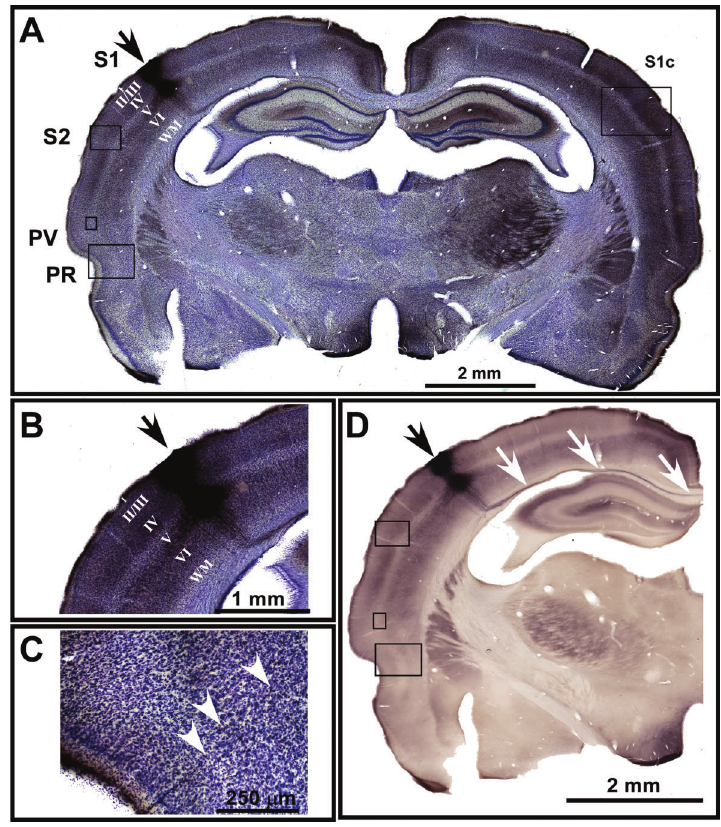
Figure 2 . Histological rat brain section double- stained with Nissl showing the laminar location of labeled corticocortical axon terminals after a single iontophoretic injection of biotinylated dex- tran amine in S1. A , Low-power photomontage of the same coronal section depicted in Figure 1. B , Photomicrograph showing cortical layers and C , anterogradely-labeled axon terminals in a section double-stained with Nissl. Arrows indicate axon terminal segments. D , Black arrow indicates injection site and white arrows indicate callosal axons. The boxes indicate cortical areas (S2, PV and PR) where axon fragments labeled with DBA were reconstructed. Cortical layers are indicated by roman numerals, from I to VI; WM: white